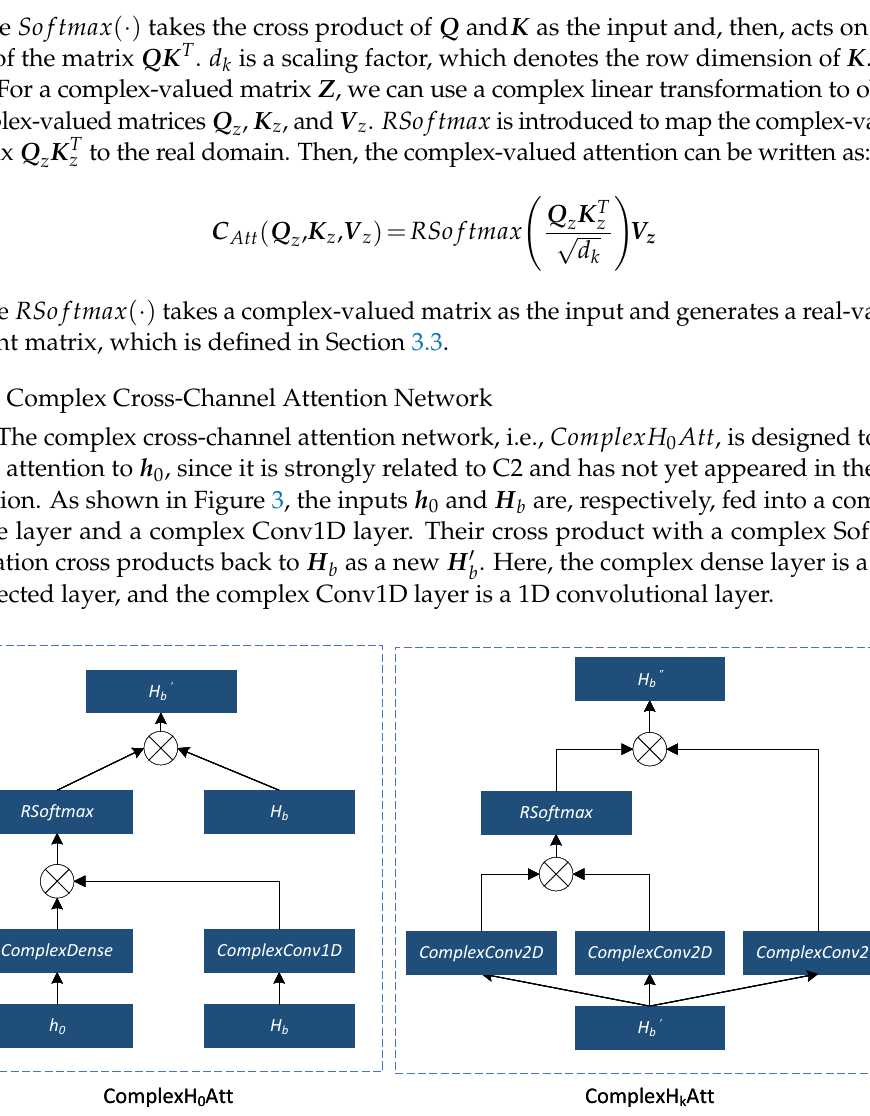
Figure 3. The structure of the complex-valued attention network